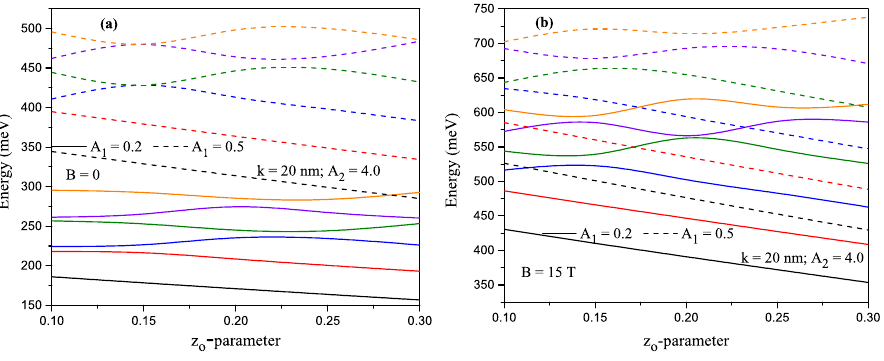
Figure 3. For A 2 = 2.0, the variation of the energies that corresponds to the first six lower-lying levels of a confined electron within Harmonic-Gaussian asymmetric DQW as a function of the z 0 -parameter. Solid (dashed) lines are for A 1 = 0.2 ( A 1 = 0.5). Results are for B = 0 ( a ) and B = 15T ( b ).